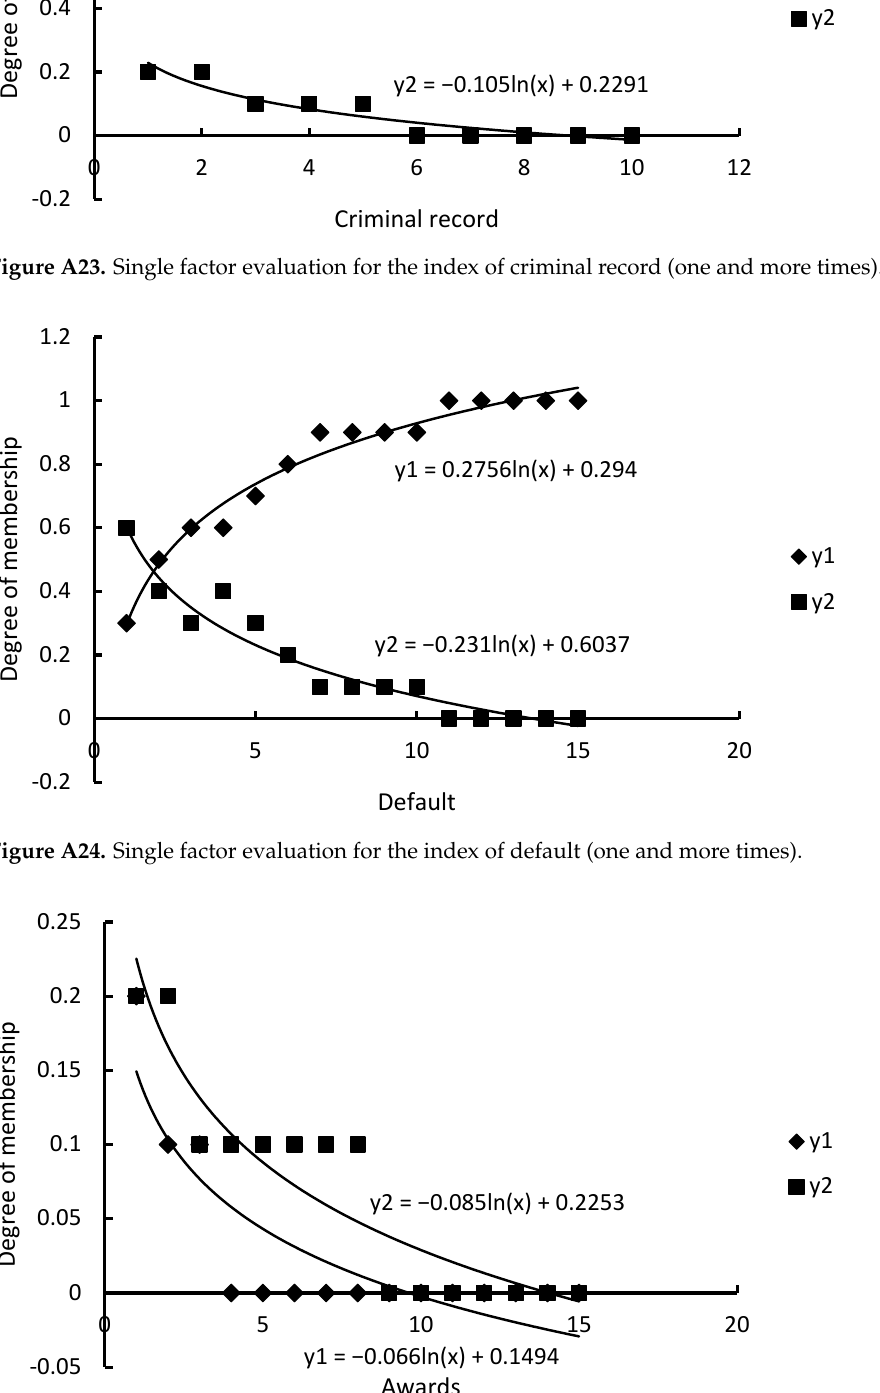
y1 = −0.066ln(x) + 0.1494